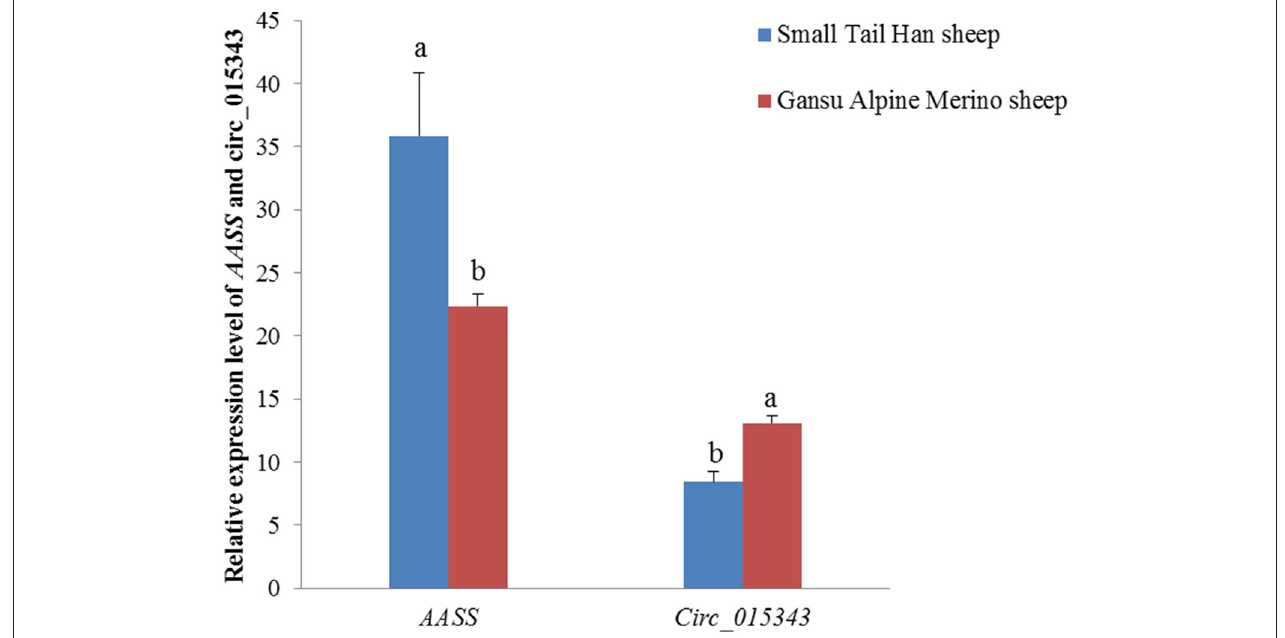
FIGURE 4 | Relative expression levels of AASS and circ_015343 in the mammary gland tissue at peak-lactation period in Small Tail Han sheep and Gansu Alpine Merino sheep. Different lowercase letters above the bars represent significant differences ( p < 0.05) between the two